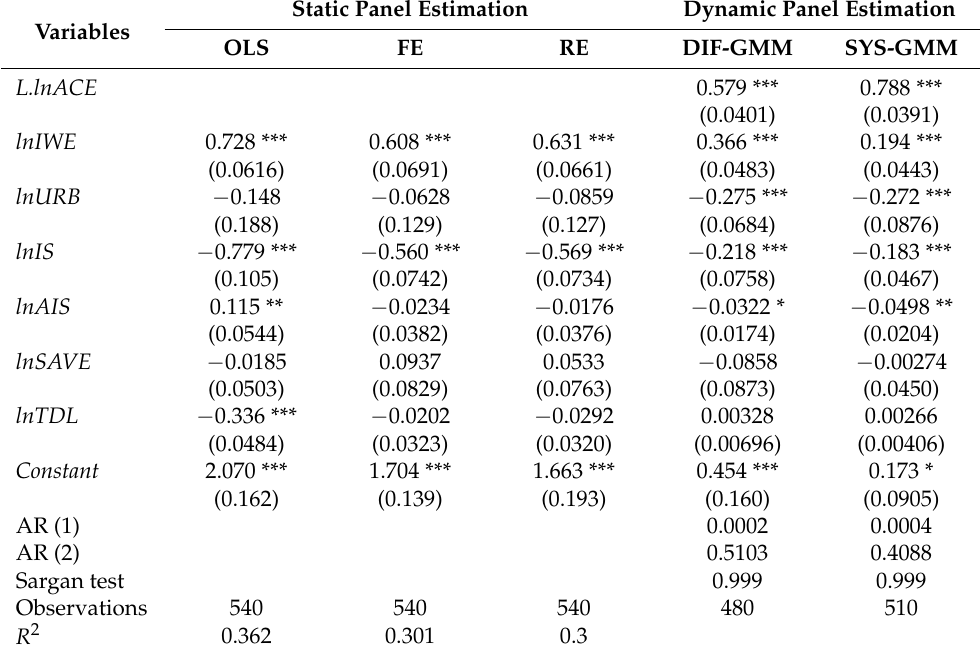
Table 4. Estimation of IWE–ACE